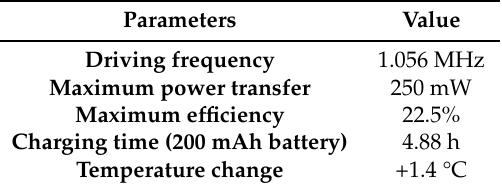
Table 1. Key parameters for ultrasonic wireless power transfer across 10-mm pig skin [15].